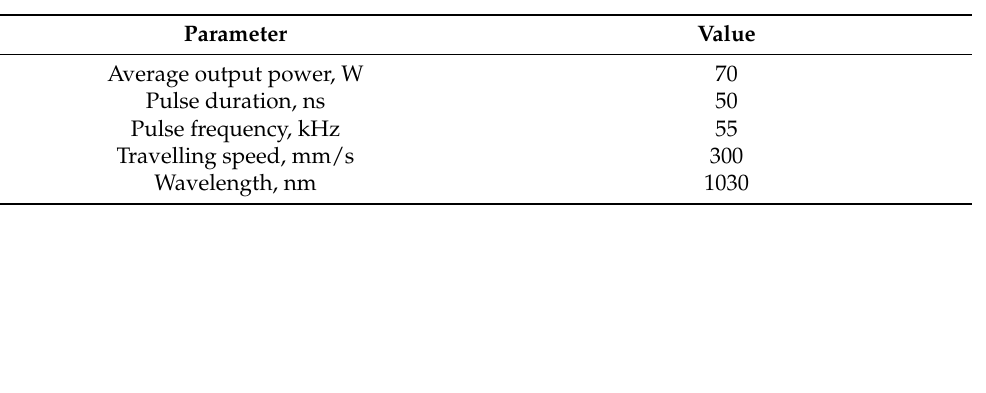
Table 2. Main parameters of nanosecond laser micro-machining process.